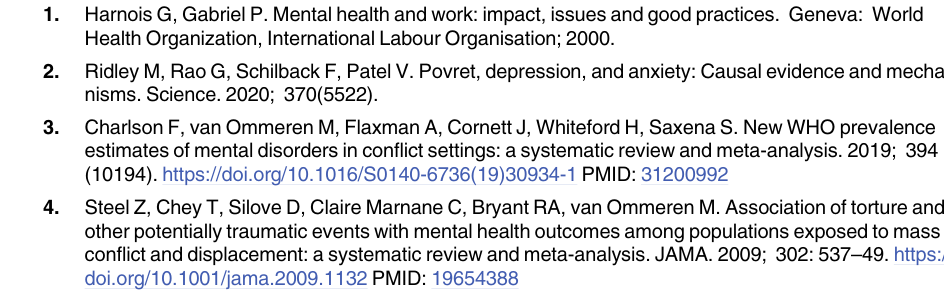
S1 Table. Balance tests between the therapy and no-therapy groups at